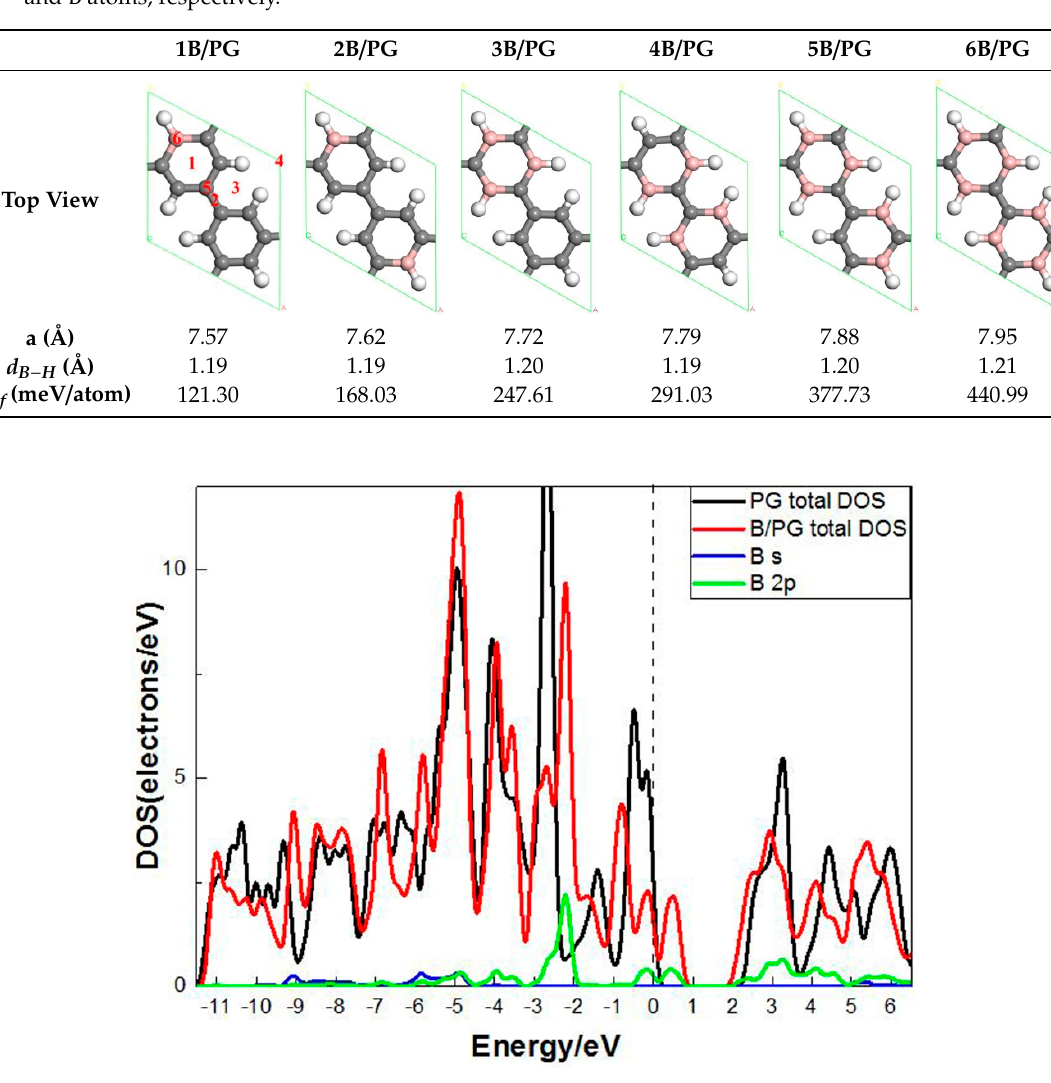
Figure 1. DOS of the porous graphene system with and without B-doped.